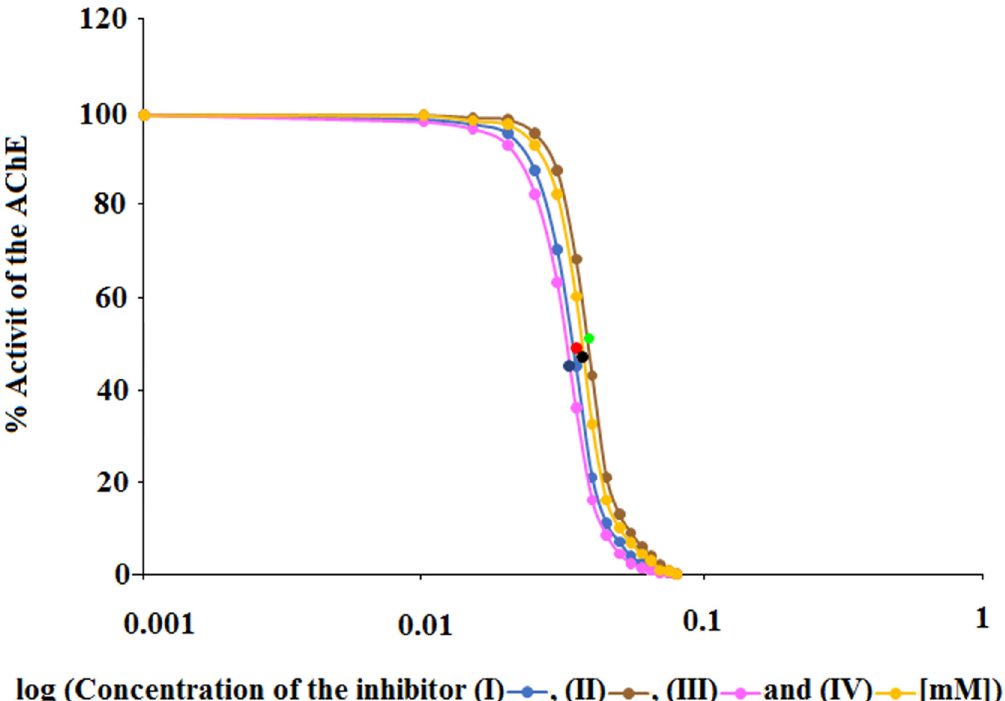
Figure 5. Graphical determination of IC 50 for (I), (II), (III) and (IV) acetylcholinesterase inhibitors. Based on a comparison of the IC 50 values for compound (III) (0.033 ± 0.001 mM), compound (IV) (0.035 ± 0.001 mM), compound (I) (0.037 ± 0.001 mM) and compound (II) (0.039